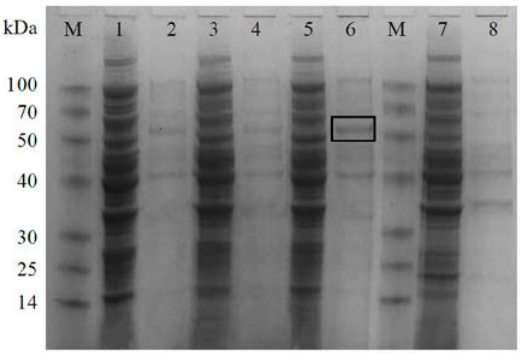
Figure 8. SDS-PAGE of the recombinant protein CiPlant-CRY1 induced by IPTG. M: Marker, 1: Uninduced CiPlant-CRY1 supernatant, 2: Uninduced CiPlant-CRY1 precipitate, 3: CiPlant-CRY1 supernatant induced by 0.2 mM IPTG, 4: CiPlant-CRY1 precipitate induced by 0.2 mM IPTG, 5: CiPlant-CRY1 supernatant induced by 0.5 mM IPTG, 6: CiPlant-CRY1 precipitate induced by 0.5 mM IPTG, 7: No-load bacterial supernatant induced by 0.5 mM IPTG, 8: No-load bacterial precipitate induced by 0.5 mM IPTG.